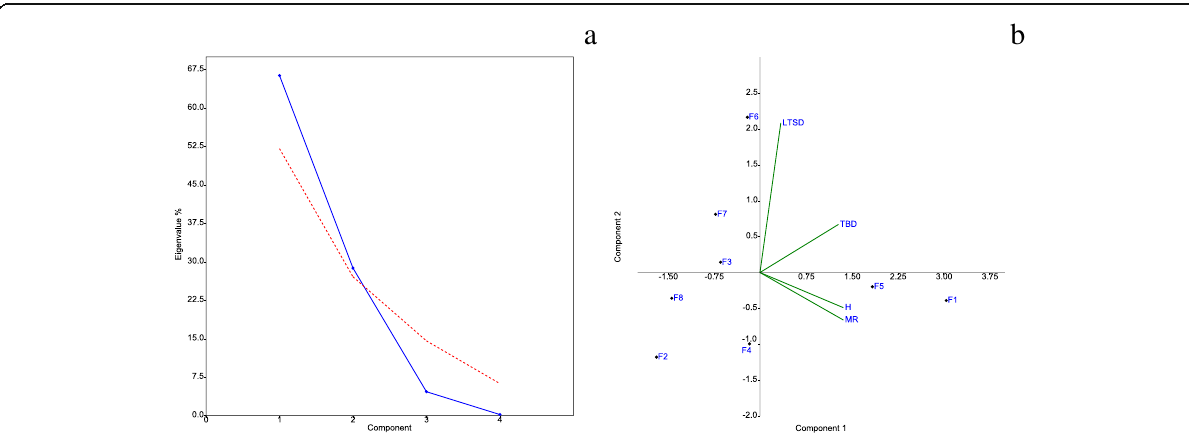
Fig. 5 Representation of PCA analysis. a Scree plot indicating the number of significant principal components. Red dot-dash line indicates the broken stick model, eigenvalues under this curve are non-significant. b PCA bi-plot representing the ordination of sites (F1 – F8) and variables (green lines)